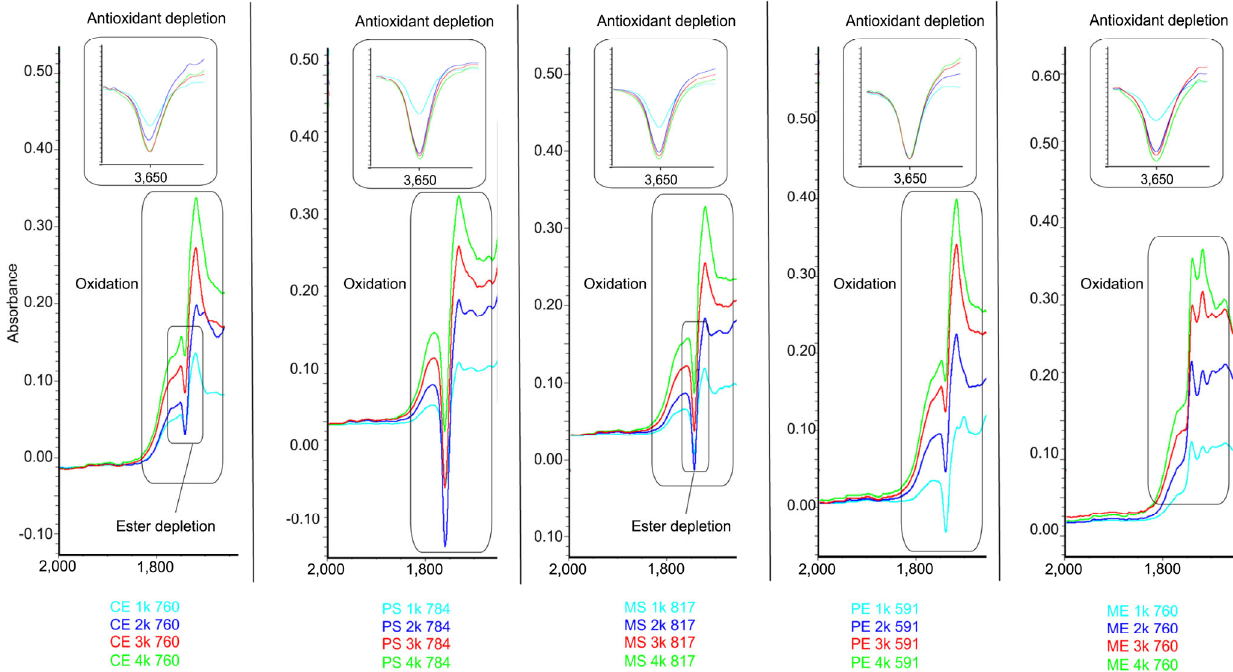
Fig. 1 FTIR differential spectra for each group of samples, the regions 3,600–3,700 cm − 1 and 1,700–2,000 cm − 1 .